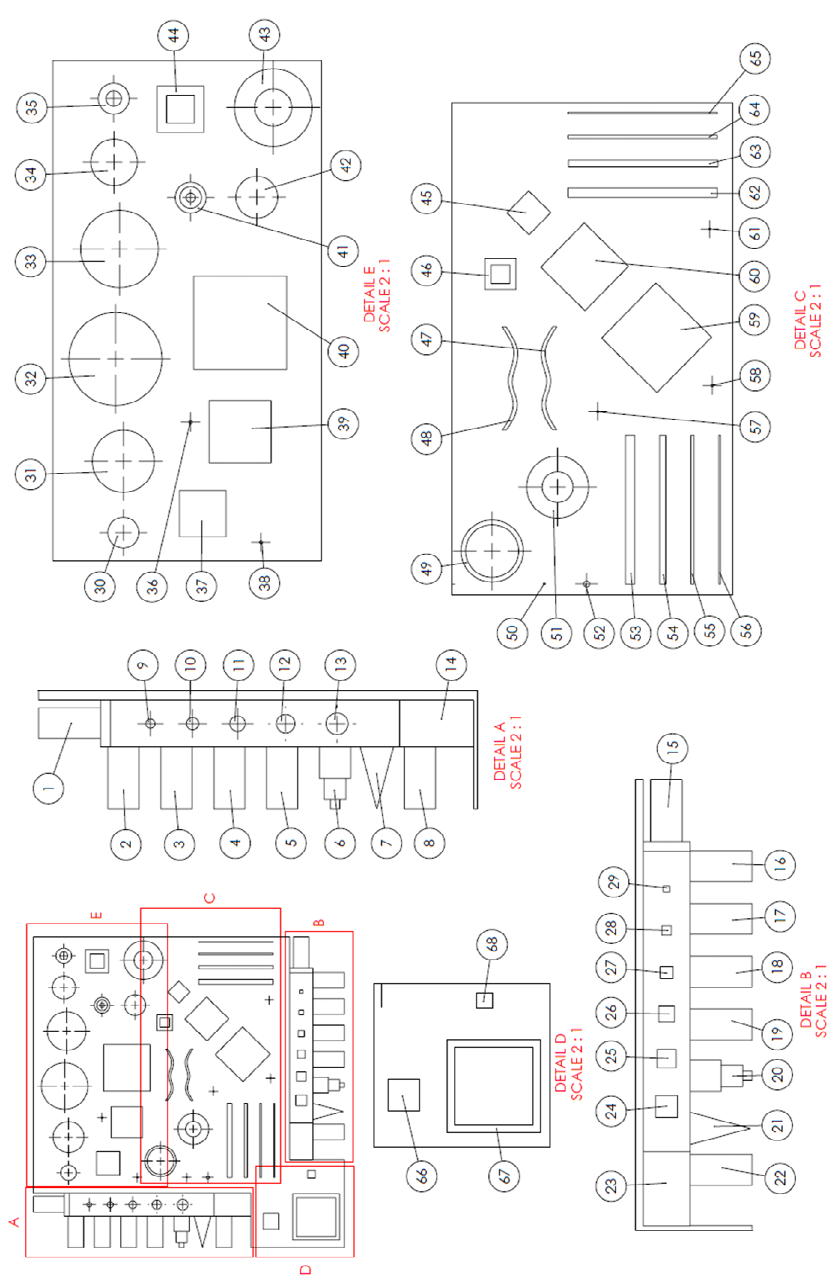
Figure A1. GBTA drawing depicting all the features along with their numbering.